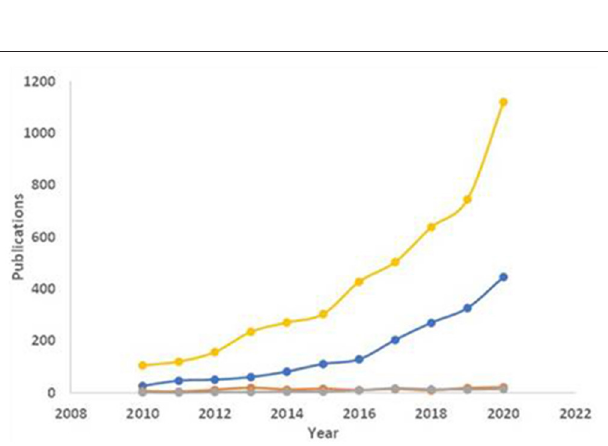
FIGURE 3 | Life cycle assessment (LCA) of the three types of bioplastics: ( (cid:4) ) biobased but non-biodegradable polymers; ( (cid:4) ) plastics that are biodegradable and based on fossil resources, and ( (cid:4) ) polymers that are both biobased and biodegradable.